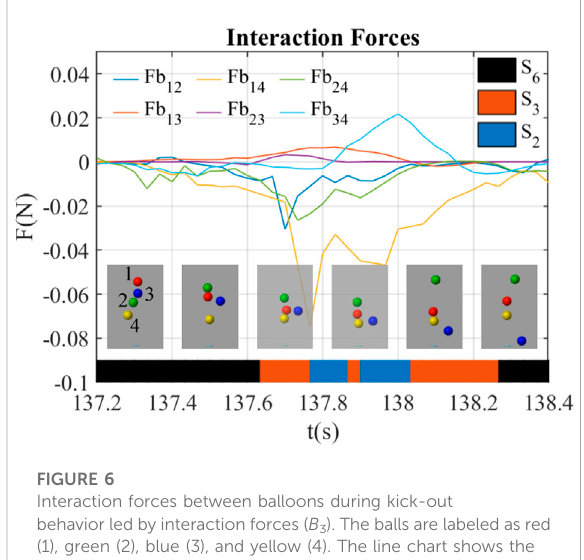
FIGURE 6 Interaction forces between balloons during kick-out behavior led by interaction forces ( B 3 ). The balls are labeled as red (1), green (2), blue (3), and yellow (4). The line chart shows the magnitude of interaction forces between balls. The frames show the exact positions of the balls at that time. The color bar shows the interaction states and their transfers in this period of time.